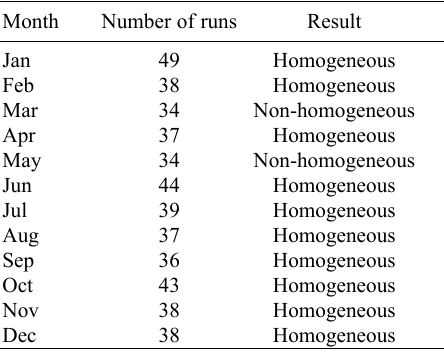
Results of run test to determine homogeneity of monthly rainfall time series Number of